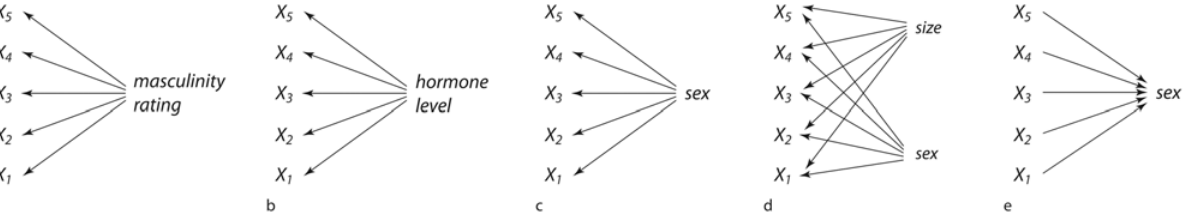
Fig 1. Path models corresponding to different multivariate methods of estimating masculinity. (a) The morphological pattern underlying perceived masculinity can be estimated by a multivariate regression of the morphometric variables ( X 1 ... X 5 ) on a masculinity rating. (b) The morphological effects of steroid hormones can be estimated by a multivariate regression of the morphometric variables on a measure of hormone level. (c) The difference between average male and average female shape is equivalent to a regression of morphology on sex (as a binary variable). (d) Allometric and non-allometric components of sexual dimorphism can be estimated by regressing morphology on both size and sex. (e) A discriminant function is computationally equivalent to a multiple regression of sex on the morphological measurements.